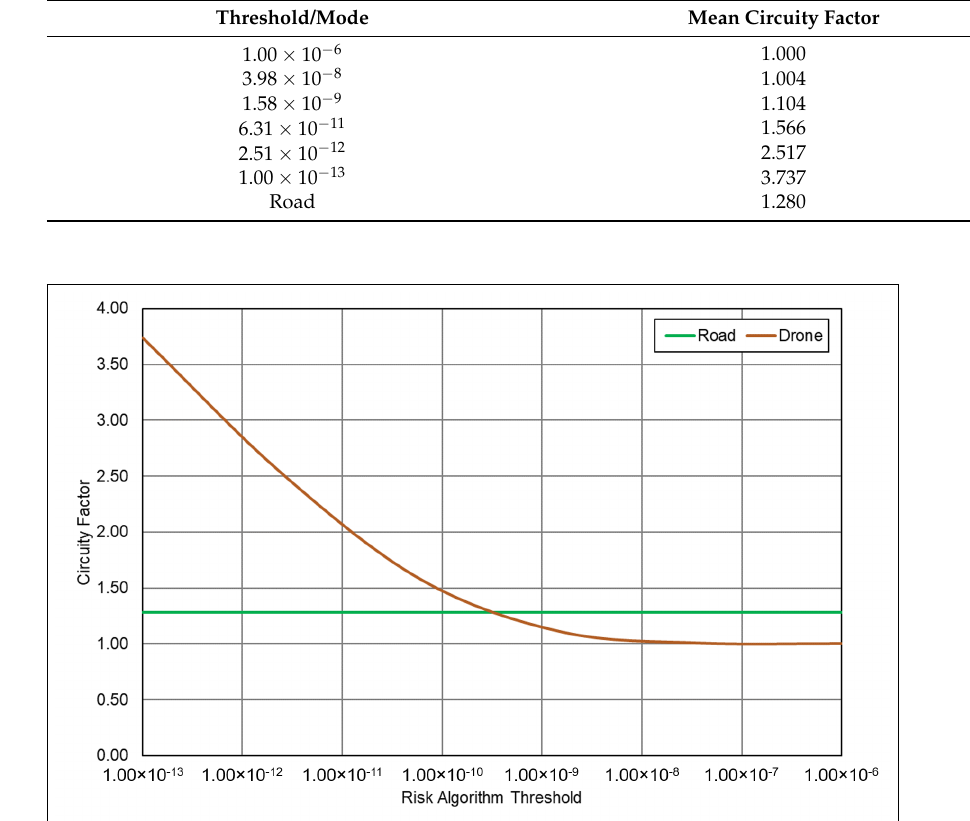
Figure 9. Mean Circuity Factor with Increasing Risk vs. Road Travel